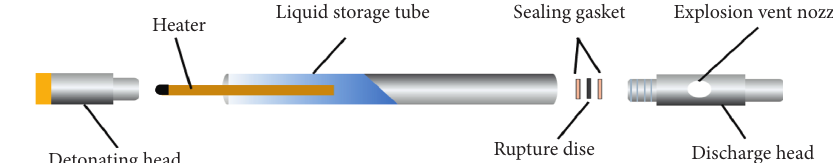
Figure 1: Structure diagram of the carbon dioxide phase change fracturing tube.